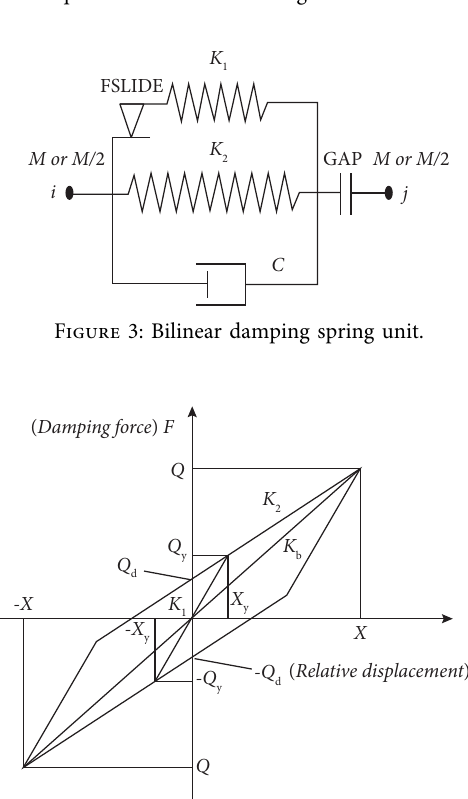
Figure 2: Equivalent bilinear restoring force model of bearing.